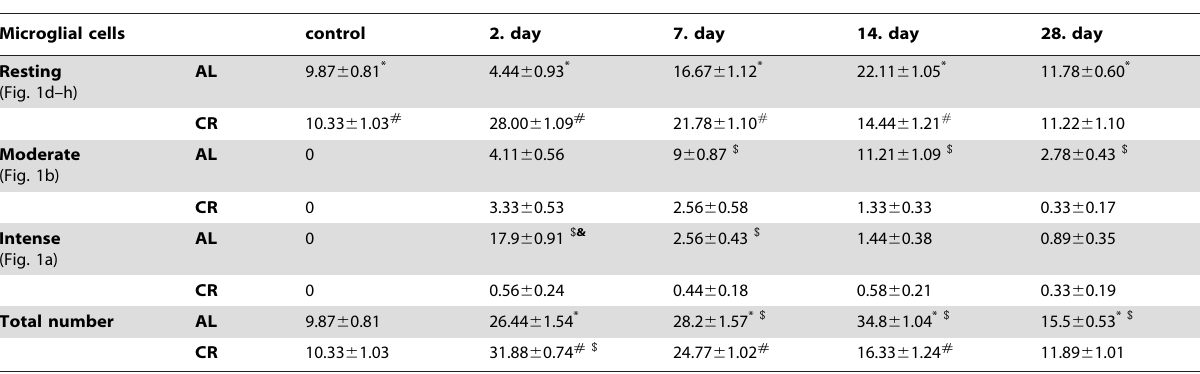
Number of Iba-1 positive cells classified according to their morphology in the perilesioned area 2,7,14 and 28 days following SCI in AL and CR animals. Data are expressed as means 6 S.E.M. (n=3 animals per experimental group). *p , 0.05 vs. AL control; # p , 0.05 vs. CR control;